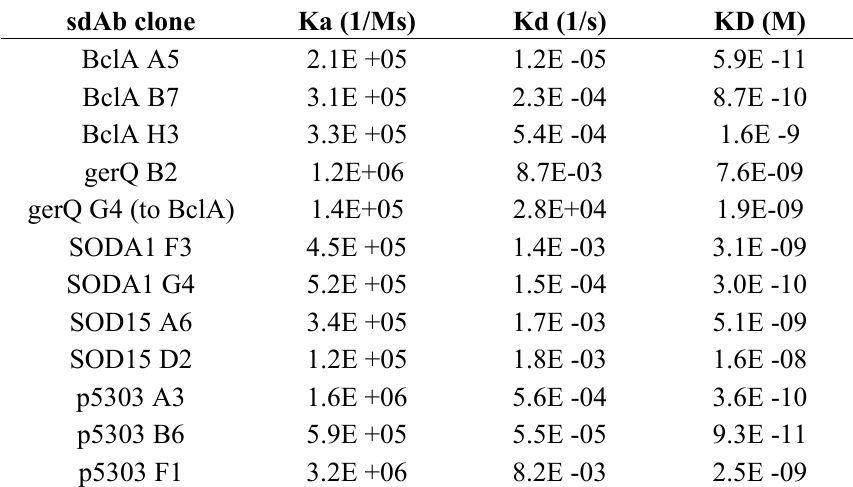
Table 1. SdAb binding kinetics for recombinant